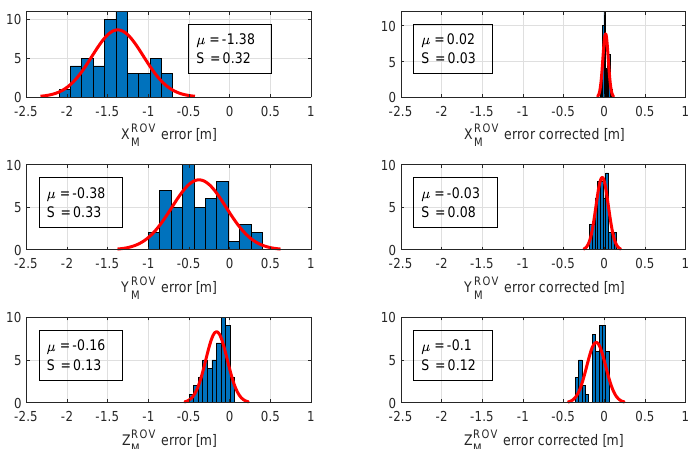
Figure 10. Position error distribution in marker frame before ( left column ) and after correction ( right column ).